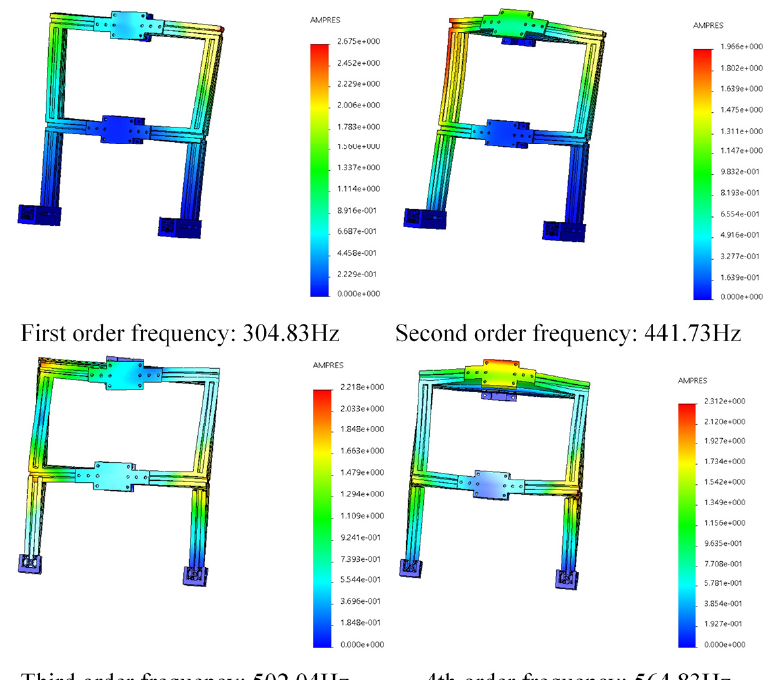
Figure 11. The vibration nephogram.